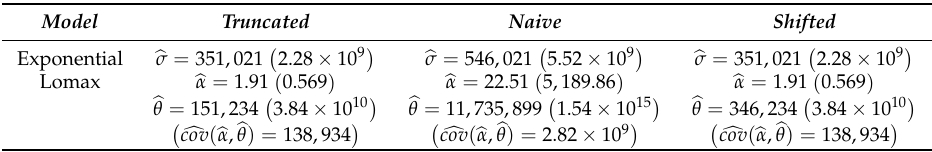
Table 4. Parameter maximum likelihood estimators (MLEs, with variance and covariance estimates in parentheses) of the exponential and Lomax models, using truncated, naive, and shifted